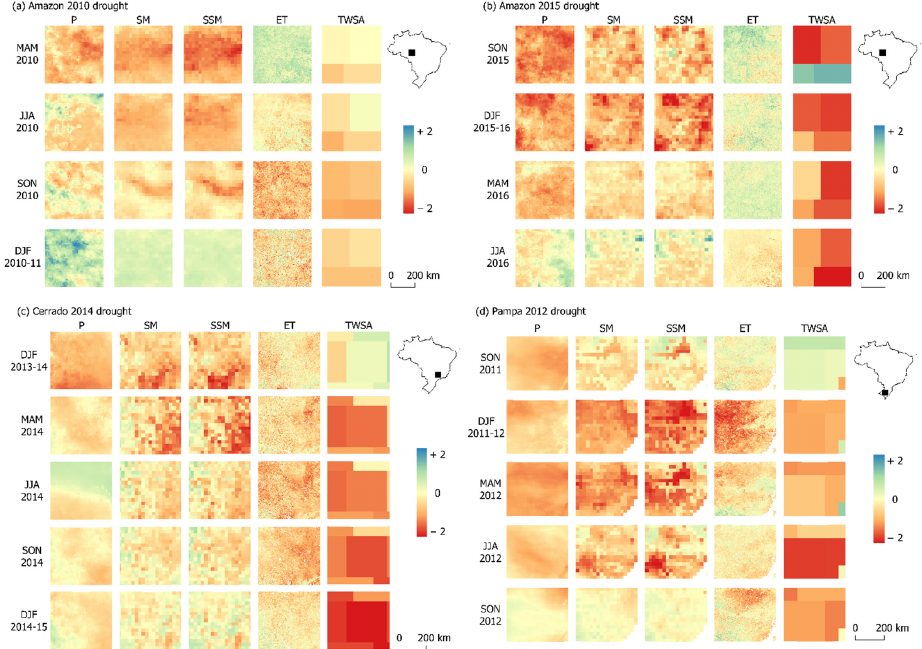
Figure 3. Area affected by monthly anomalous values from − 2 to 2 for precipitation ( P ), surface soil moisture ( SM ), subsurface soil moisture ( SSM ), evapotranspiration ( ET ), and terrestrial water storage anomalies ( TWSA ), for the Amazon, Cerrado and Pampa.